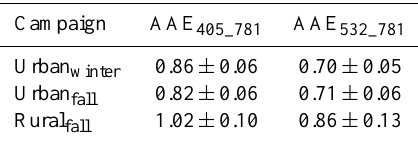
Table 2. The derived AAE BC values and uncertainties in the differ- ent